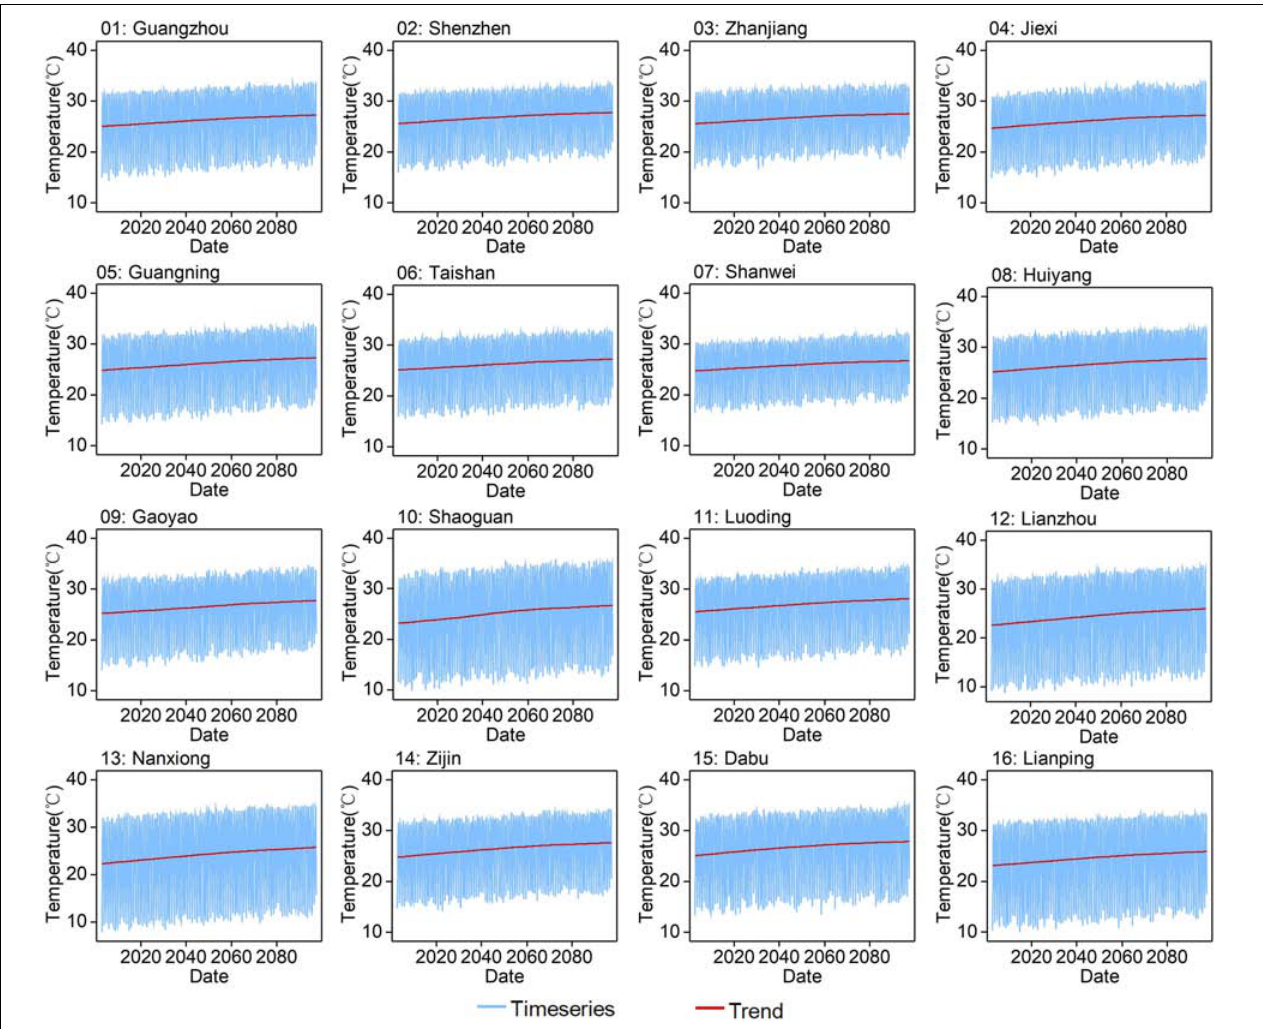
FIGURE 6 | Monthly projected Tmax of the ensemble of GCMs (i.e., CNRM-CM5, CSIRO-Mk3.6.0, IPSL-CM5A-MR, and MIROC5) from 2006 to 2100 under